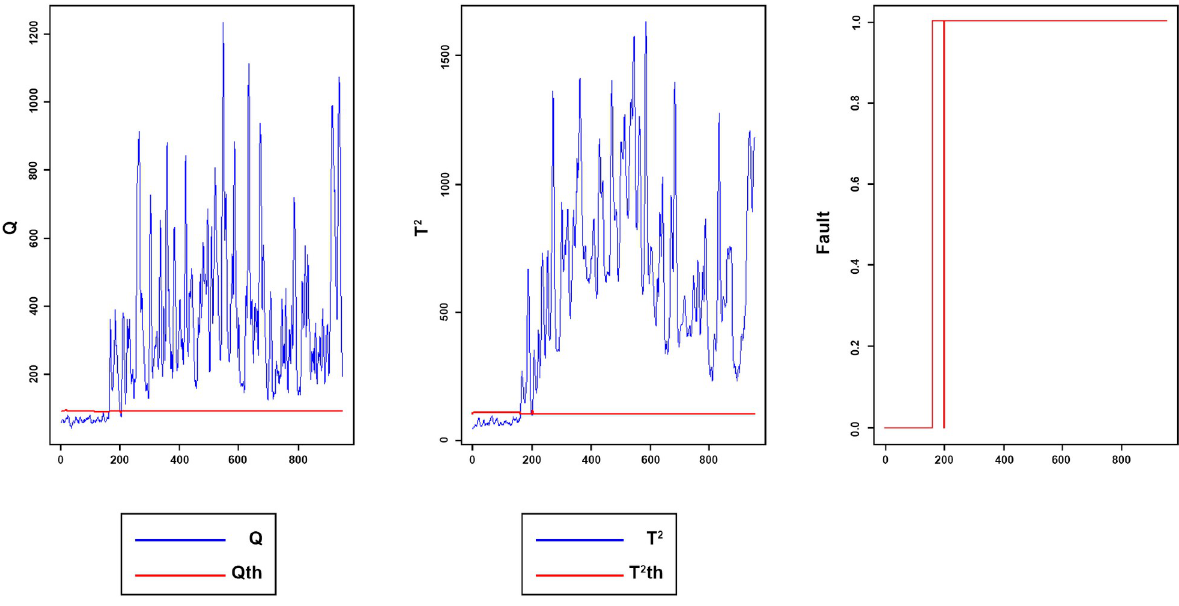
Fig 12. Monitoring performance of MWDPCA for fault